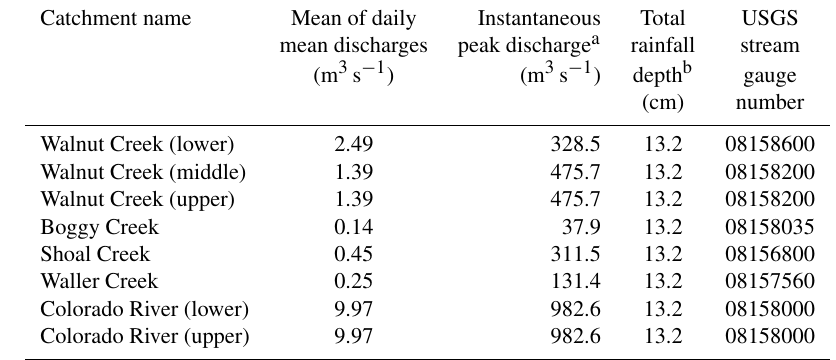
Table 1. Austin, Texas, catchment characteristics.